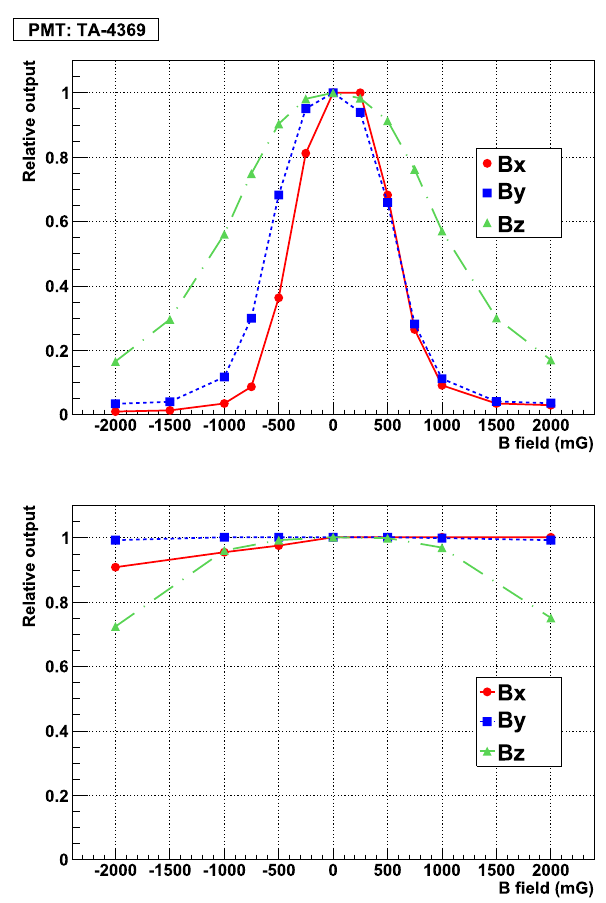
Fig. 13 Relative charge response of the Hamamatsu R7081 PMT with respect to that at zero B-field for various values and directions (X and Y arethetransversedirectionsandZthelongitudinaldirectionwithrespect to the PMT) of the magnetic field before (top) and after (bottom) the mu-metal shield